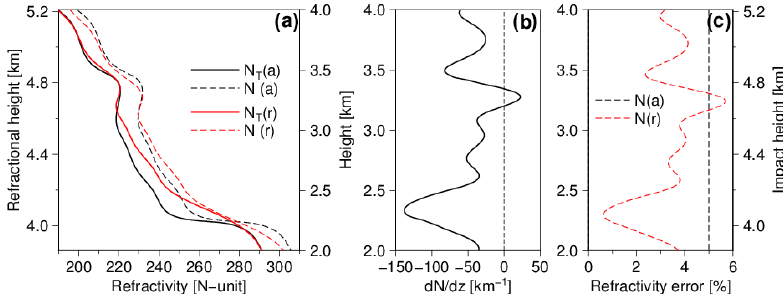
Figure 8. An illustrative example of true error versus apparent error. (a) Black lines represent the true refractivity (solid) and a hypothetical solution (dashed) in the refractional radius coordinate. The hypothetical solution is set to be 5% larger than the true refractivity in all heights. Red lines indicate those in the height coordinate, the true refractivity (solid) and the solution (dashed). (b) The vertical gradient of the true refractivity. (c) The true error (dashed black) and apparent error (dashed red), which are defined as the departure from the true refractivity in the same coordinate, i.e., dashed line minus solid line of the same color in panel (a)